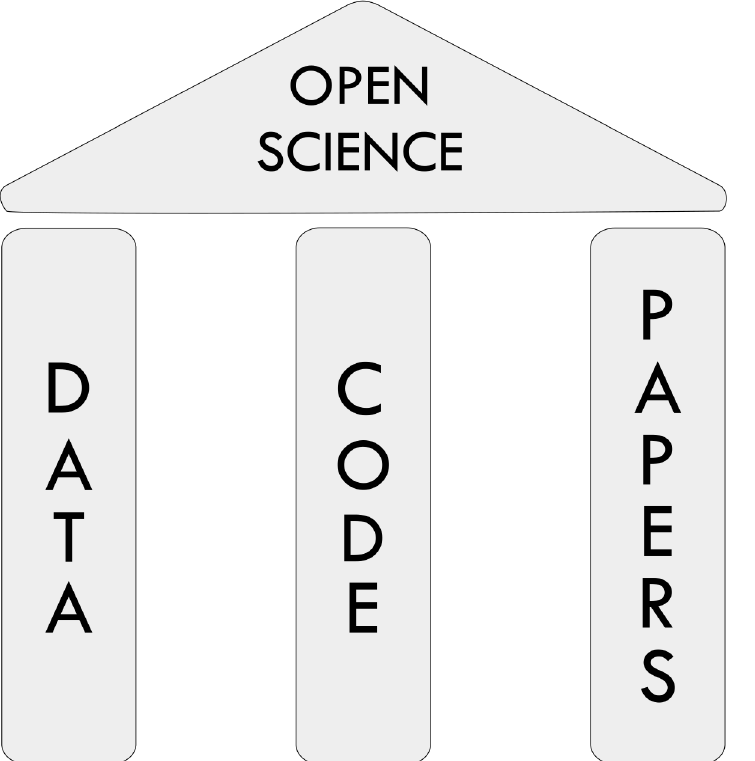
Fig 1. Three pillars of Open Science: data, code, and